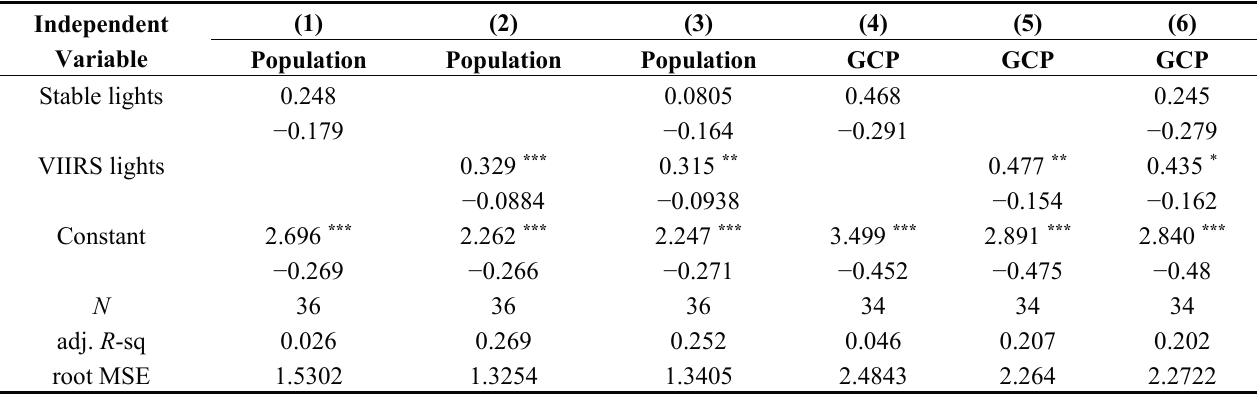
Table 6. Operational Linescan System (OLS) regression for cells with population less